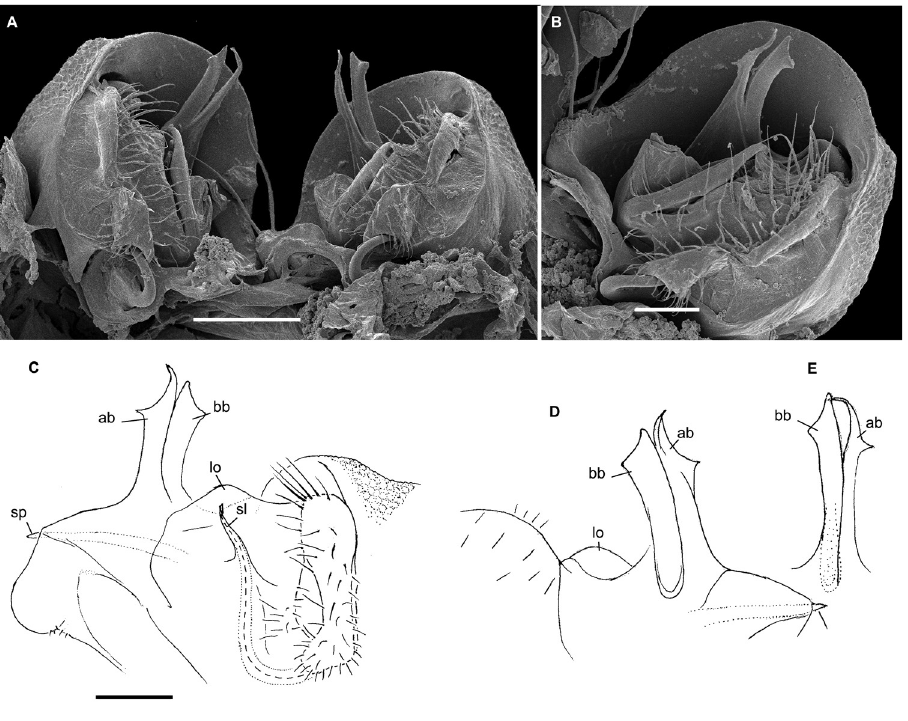
Figure 8. Hemisphaeroparia spiniger sp. n., ♂ paratypes A SEM micrographs of both gonopods in situ, caudal view B SEM micrograph of right gonopod, submesal view C, D right gonopod, mesal and lateral views, respectively E left gonod, branches ab and bb, mesal view. Scale bars: 0.1 mm ( A, C–E ), 0.5 mm ( B ). Abbreviations: ab apical branch of telopodite, bb basal branch of telopodite, lo lobe, sl solenomere, sp spiniform